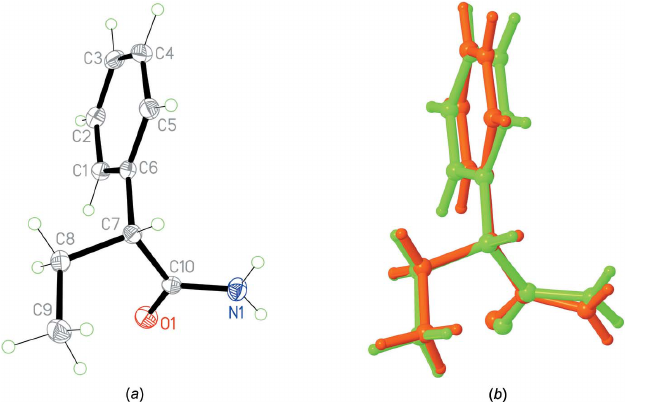
Figure 1 ( a ) View of the molecular structure of the title rac -2 polymorph with the atom labelling. Displacement ellipsoids are drawn at the 50% probability level. ( b ) Superposition of the rac -1 (red) and rac -2 (green)